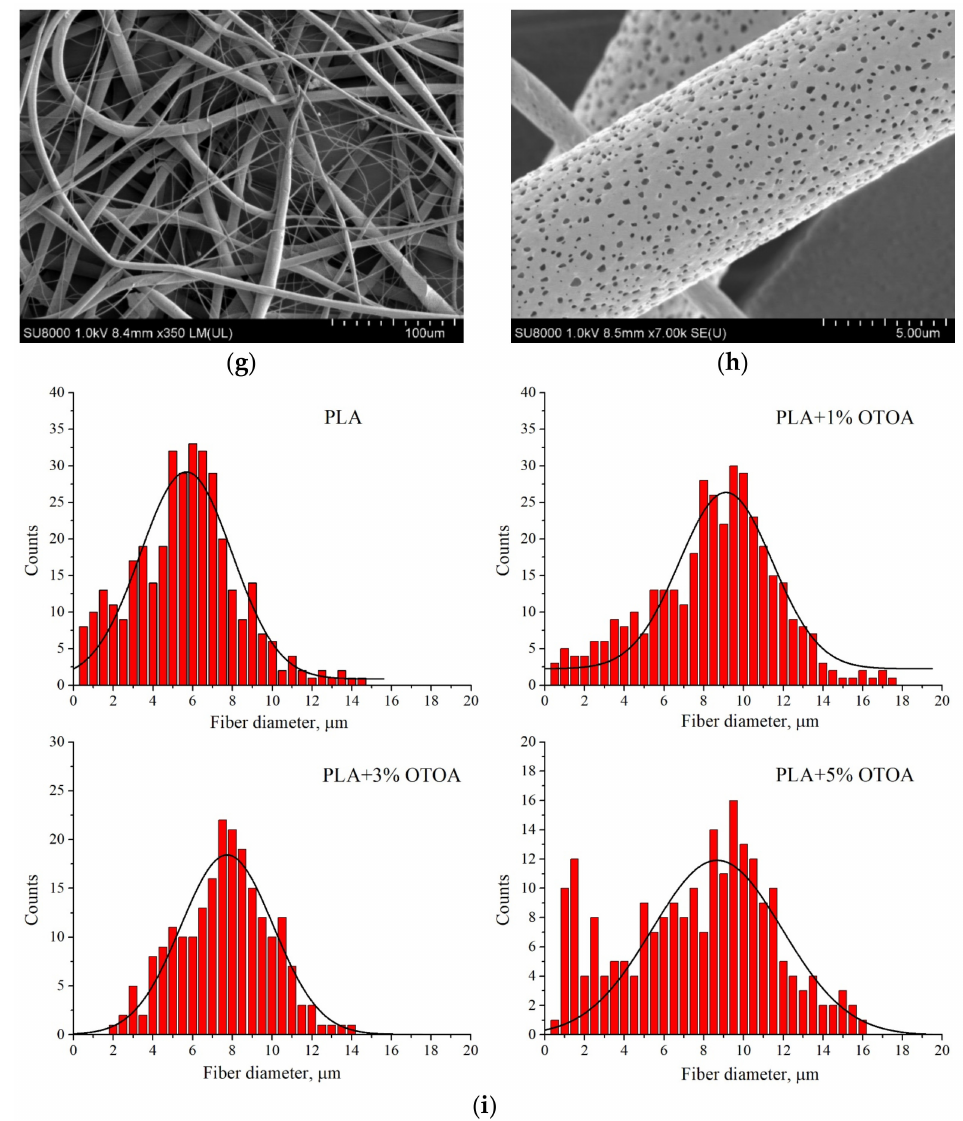
Figure 4. SEM images of nonwoven fiber PLA mats and magnified monofilaments: pristine PLA ( a , b ), PLA + 1% OTOA ( c , d ), PLA + 3% OTOA ( e , f ), PLA + 5% OTOA ( g , h ). Distributions of fiber diameters for studied PLA fibrous samples ( i ).